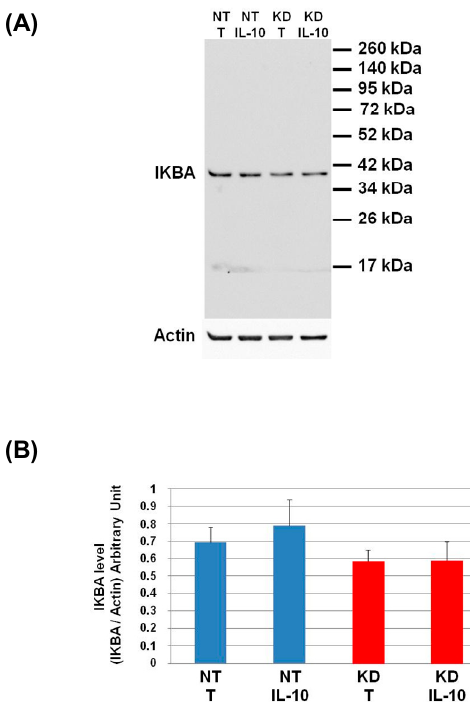
Figure 8. Study of IKBA degradation after IL-10 treatment. ( A ) NT and PC1/3 KD NR8383 macrophages were treated with 20 ng/mL of IL-10 for 24 h. Western blot studies were then conducted with anti-IKBA. ( B ) Intensities of IKBA quantified and normalized to those of Actin. The results are obtained from three independent experiments and depicted through graphic representations (means ± SD). Data are analyzed by the Student t- test. No significant differences were found.